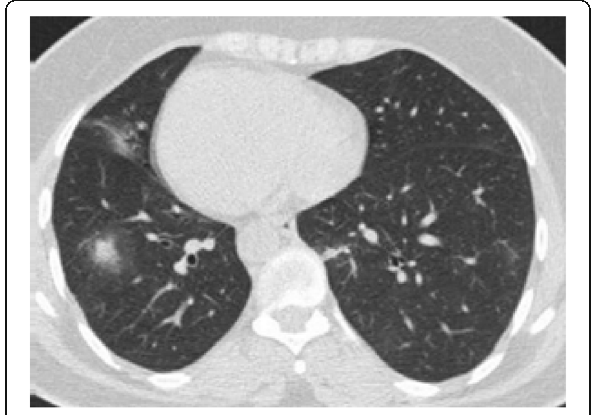
Fig. 15 COVID-19 pneumonia: thin section CT shows nodular opacity with ground glass halo